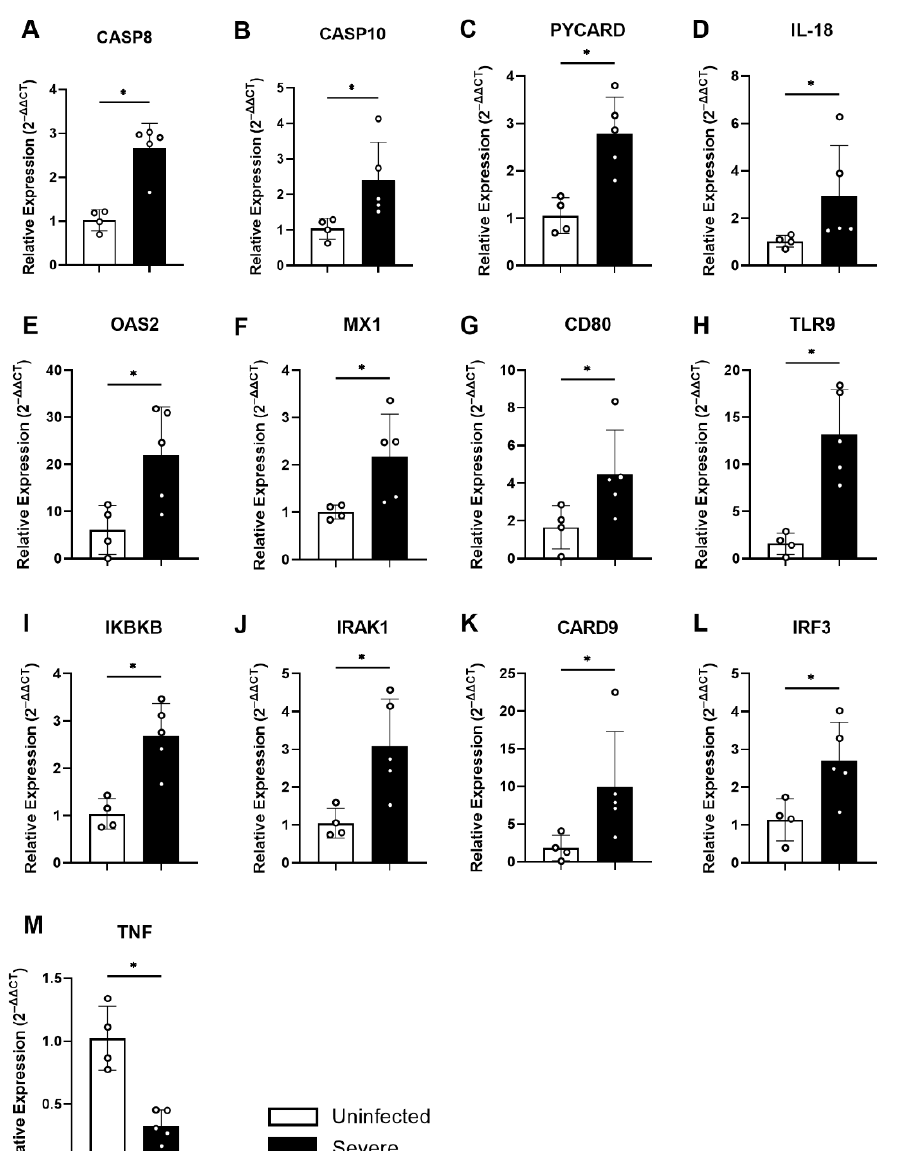
Figure 7. Differentially expressed genes in CD8+ T lymphocytes of severe COVID − 19 patients. Differential expression of antiviral factors by array PCR of CD8+ T lymphocyte genes from individuals with severe COVID − 19 compared to uninfected individuals. ( A ) Expression of CASP 8 , ( B ) CASP10 , ( C ) PYCARD , ( D ) IL-18 , ( E ) OAS2 , ( F ) MX1 , ( G ) CD80 , ( H ) TLR9 , ( I ) IKBKB , ( J ) IRAK1 , ( K ) CARD9 , ( L ) IRF3 , ( M ) TNF . The bars represent the median and interquartile range. * p < 0.05.